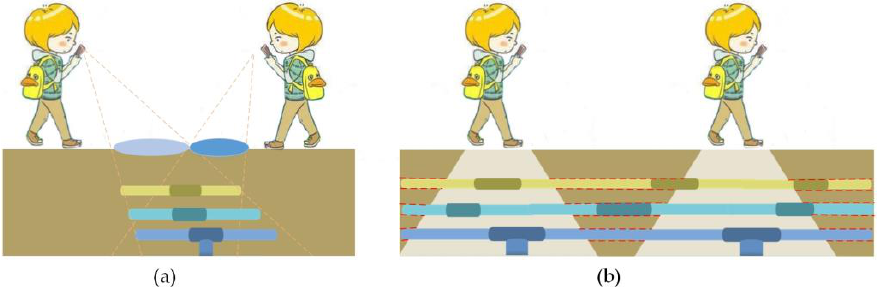
Figure 5. Ways pipelines are rendered: ( a ) in static mode, ( b ) in dynamic mode.